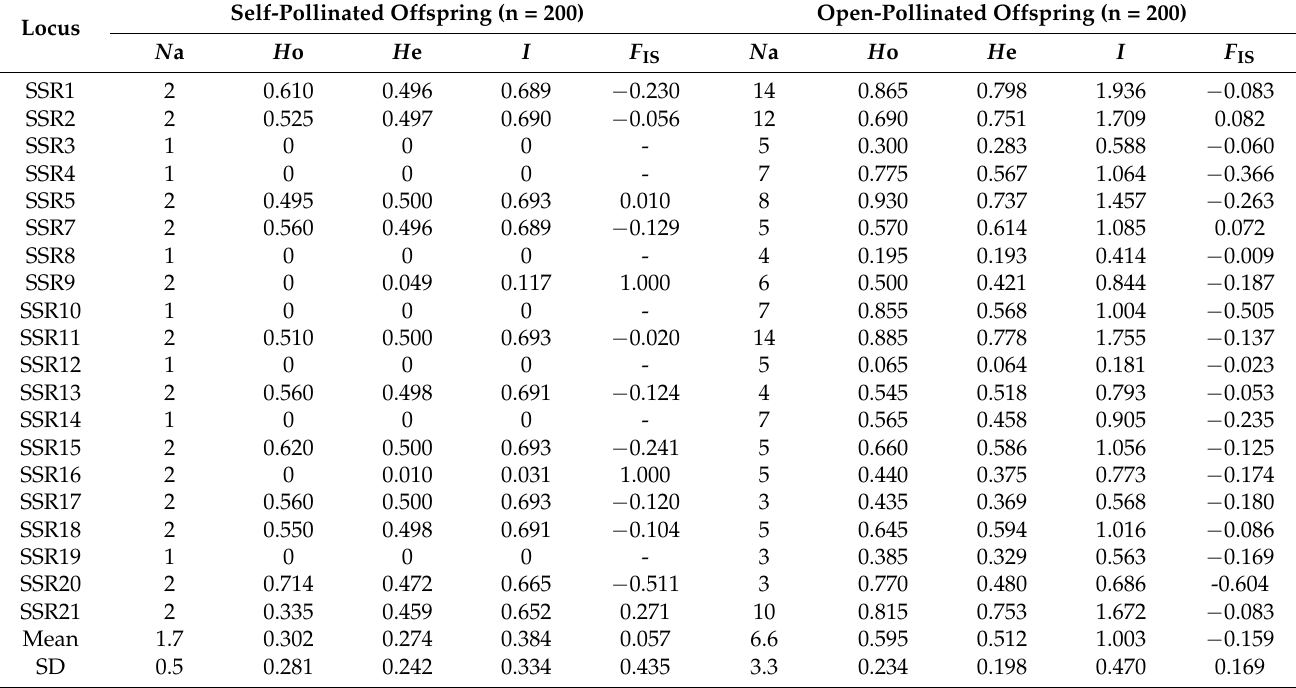
Table 1. Genetic diversity across 20 SSR loci for self- and open-pollinated offspring in clone cx569 of Chinese